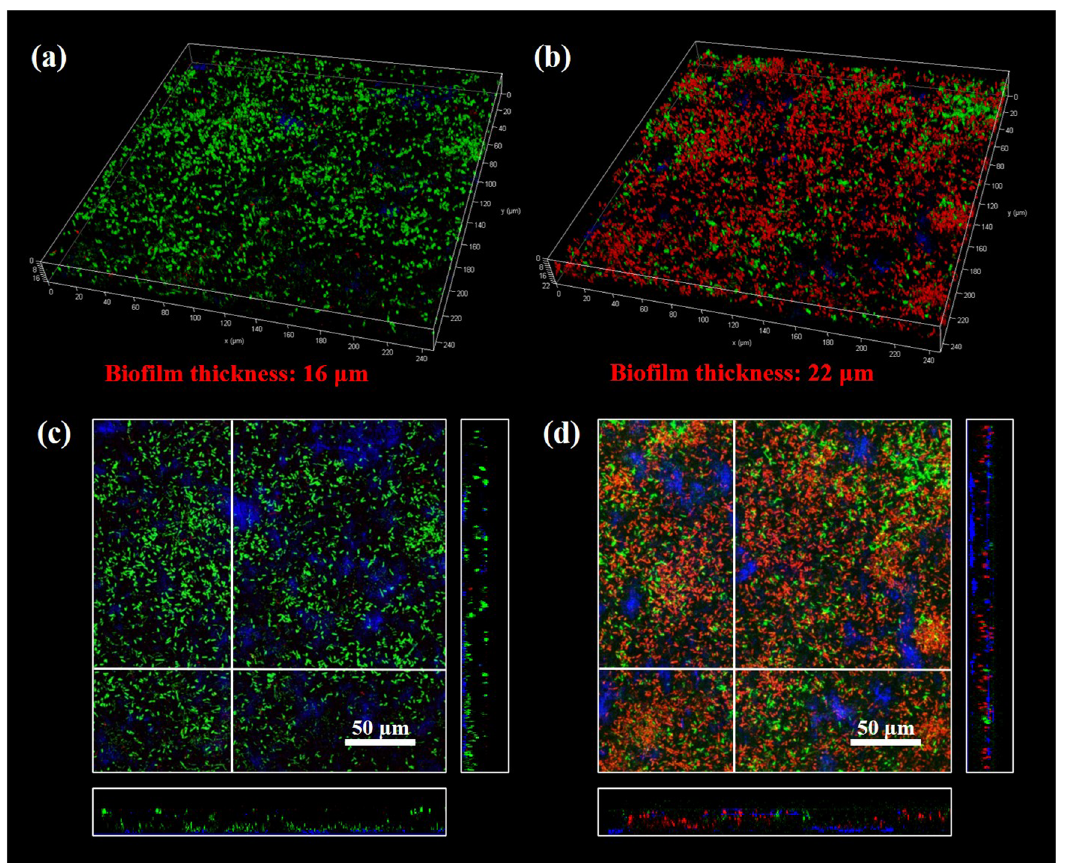
Fig. 3 CLSM images of S. putrefaciens bio fi lms on the surfaces of the Q235 carbon steel coupon. a , c after 7 days and b , d after 14